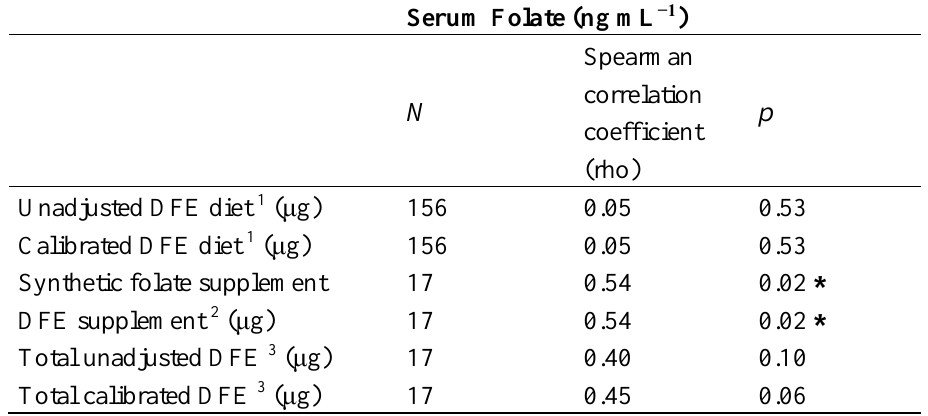
Table 2. Spearman’s rank correlation coefficient of folate intake with the dosage of serum folate in the pretreatment of patients for colorectal adenocarcinoma.